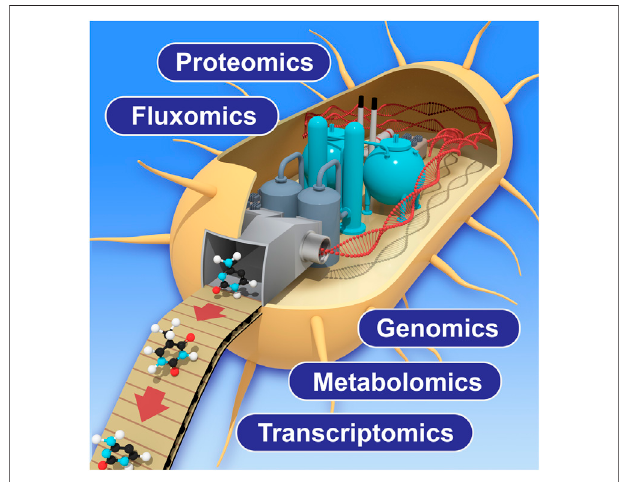
FIGURE 1 | Schematic view of multi-omics application to biomanufacturing process. Improvement of each technology will enhance the measurement coverage and accuracy in future